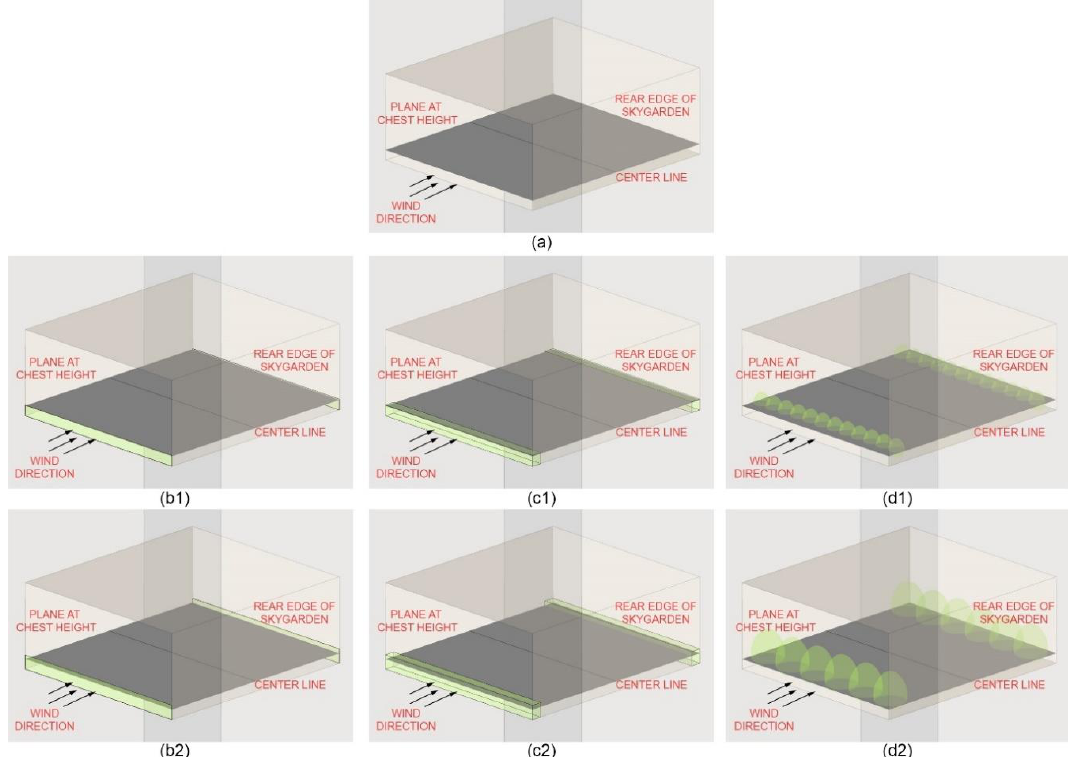
Figure 3. Arrangements within the skygarden model, with the centre line marked on the reference plane; ( a ) base skygarden configuration, skygarden with ( b1 ) 1.5 m glass railing, ( b2 ) 2 m glass railing, ( c1 ) 1.5 m hedge, ( c2 ) 2 m hedge, ( d1 ) trees of height 2.5 m, and ( d2 ) trees of height 4.5 m.